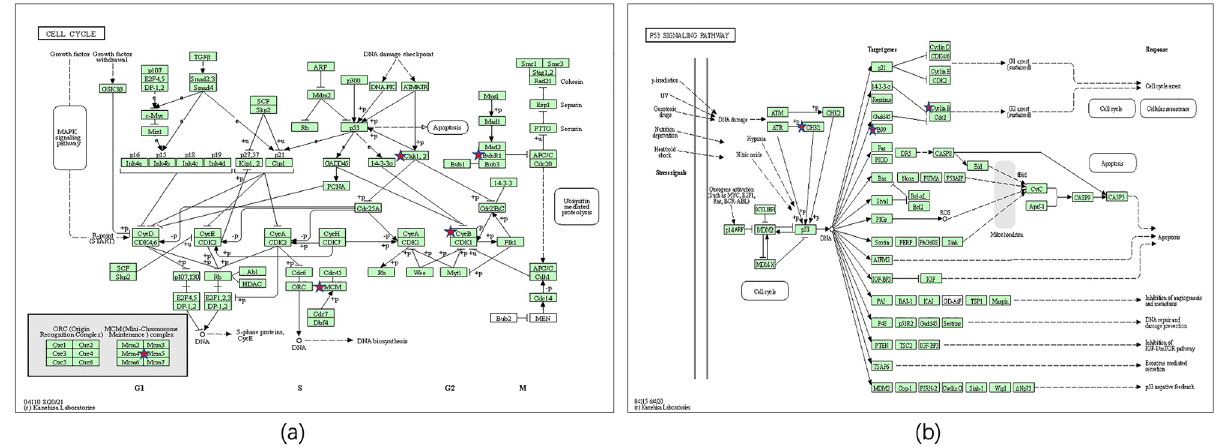
Figure 5. KEGG pathway. ( a ) Cell cycle pathway; ( b ) P53 pathway. Chk1 (CHEK1, checkpoint kinase 1), BubR1 (BUB1B, BUB1 mitotic checkpoint serine/threonine kinase B), Cyc B (cyclin B1, CCNB1), MCM5 (minichromosome maintenance complex component 5) and B99 (GTSE1, G2 and S-phase expressed